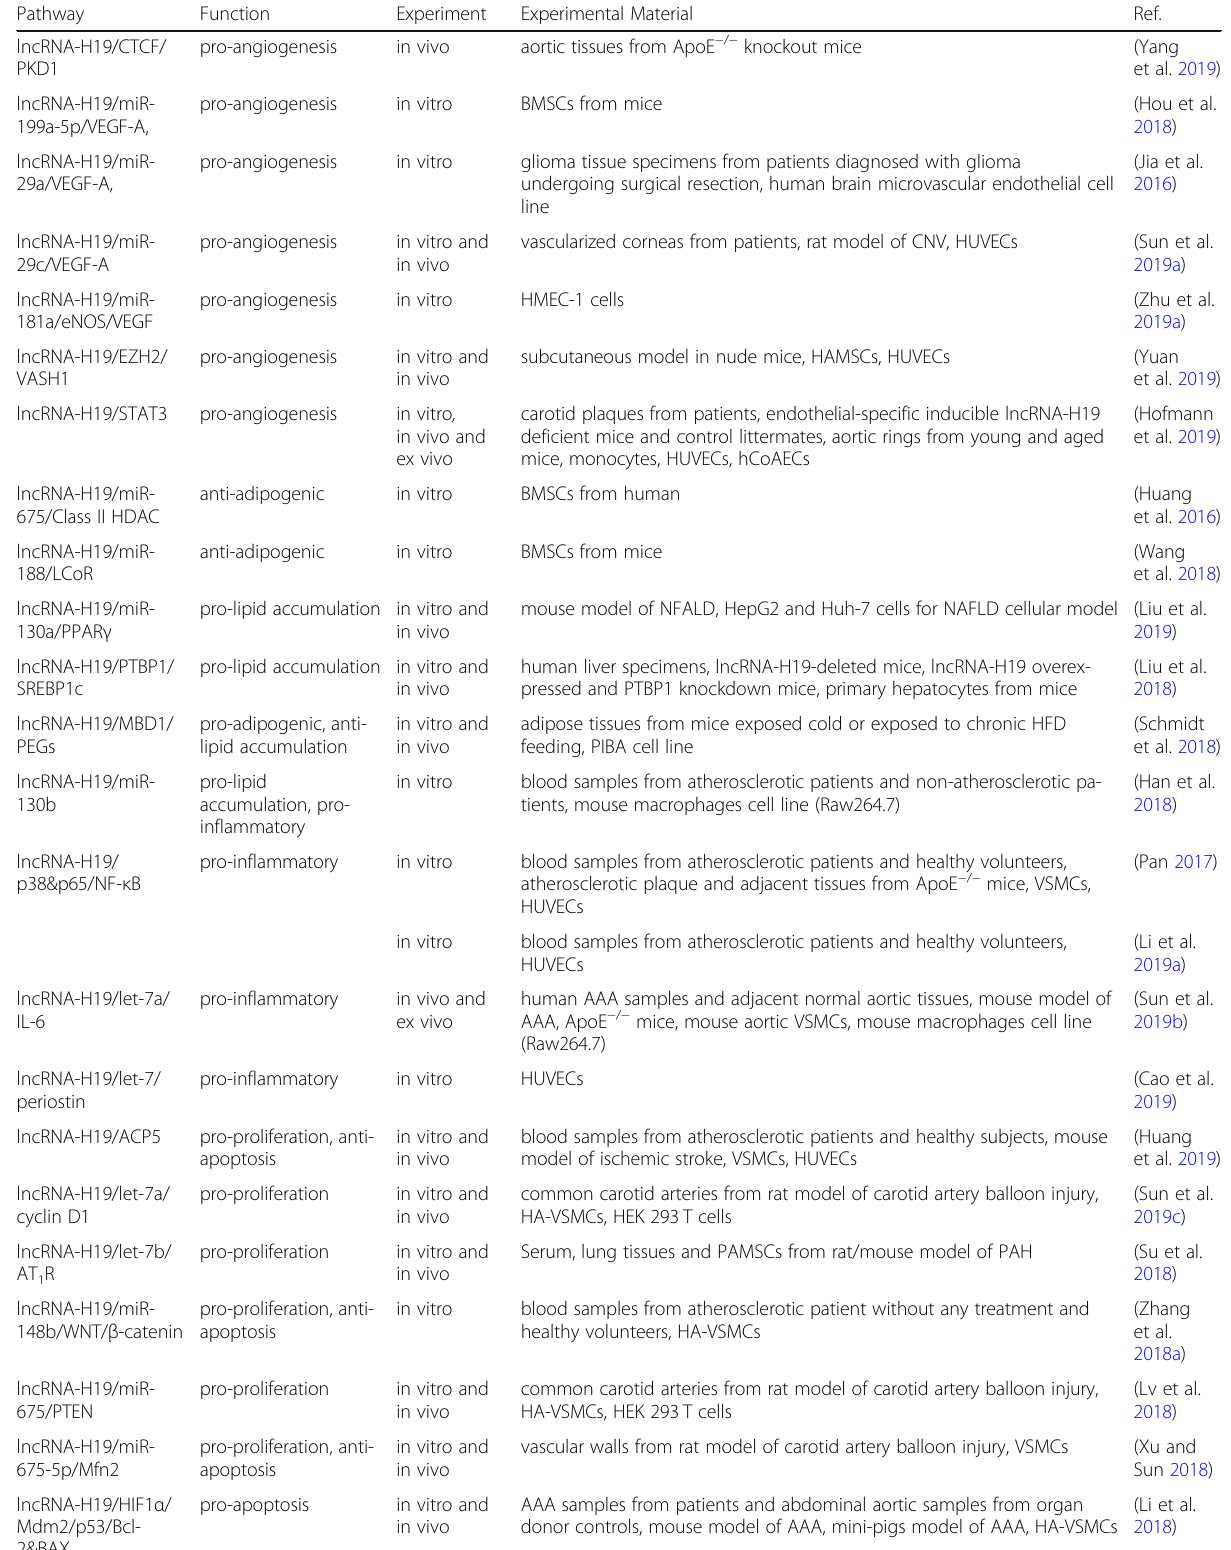
Table 1 The pathways of lncRNA-H19 in atherosclerosis-related pathophysiological processes